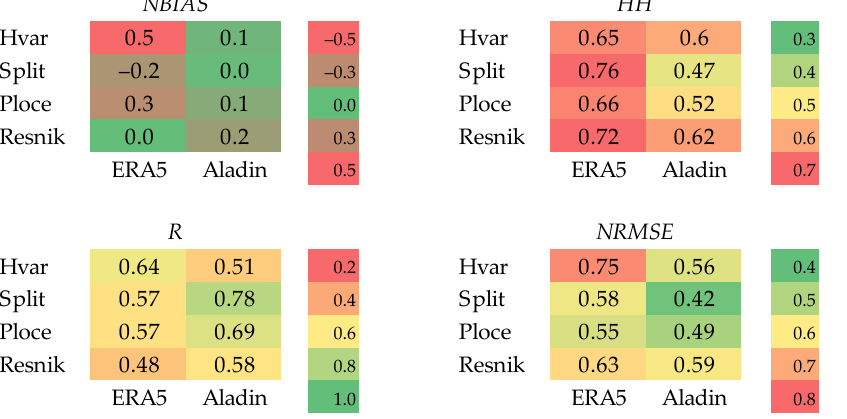
Figure 6. Performance metrics of ERA5 and ALADIN reanalysis wind data at coastal ground meteorological stations (Hvar, Split, Ploce and Resnik). Different rows of each panel represent different stations and columns represent different grided reanalysis wind data.